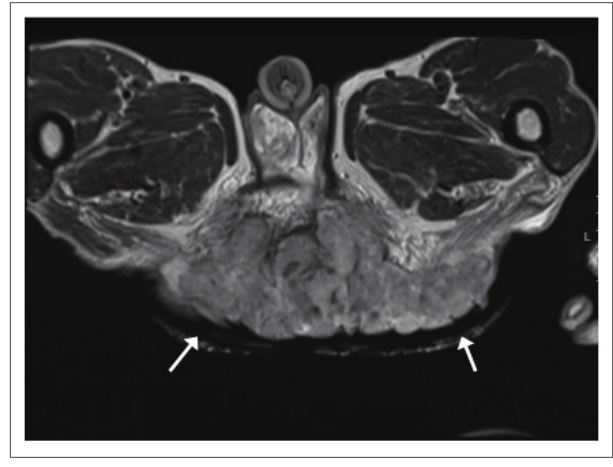
MR, magnetic resonance. FIGURE 5: T2-weighted MR imaging, axial slice of a 42-year-old male patient, demonstrating a large anal soft tissue mass (arrowed) of intermediate signal intensity, with local soft tissue invasion. Histology confirmed the diagnosis of squamous cell carcinoma.